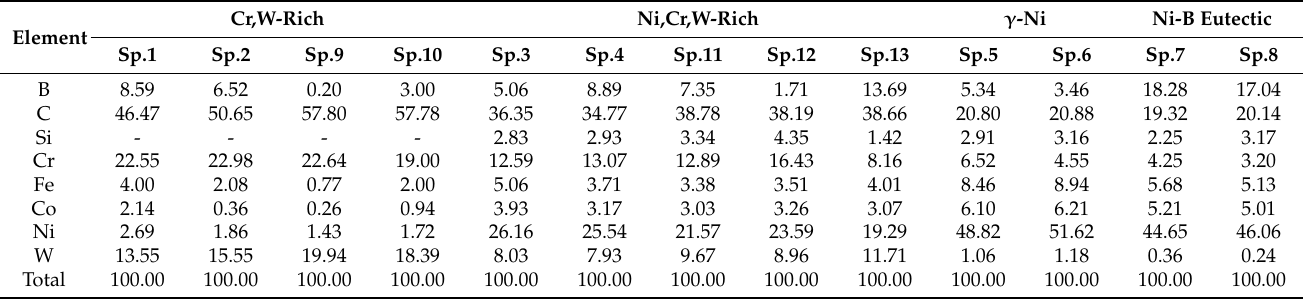
Table 3. Elemental composition of phases in laser-remelted coatings (by EDS; at. %). Element